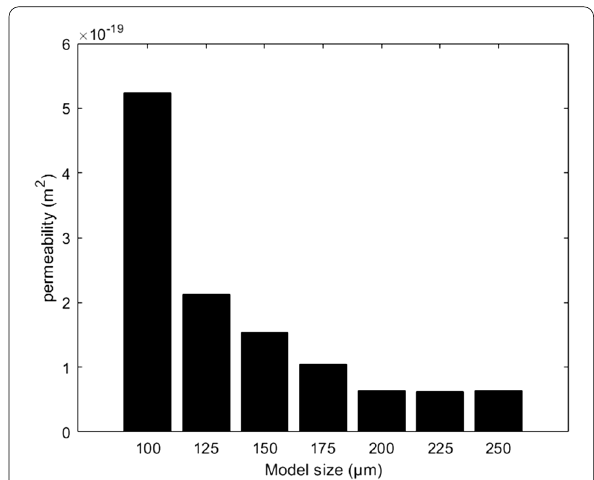
Fig. 15 Influence of model size on permeability coefficient.